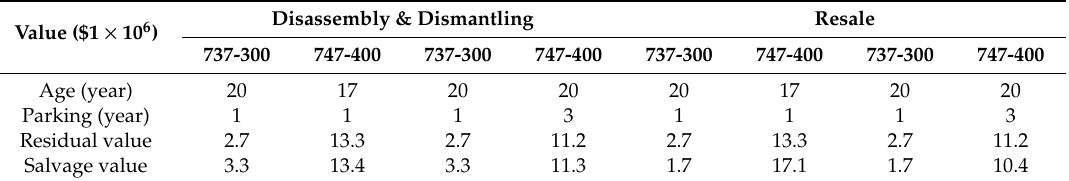
Table 11. Residual and salvage values for 737-300 and 747-400 cases (2005 USD).